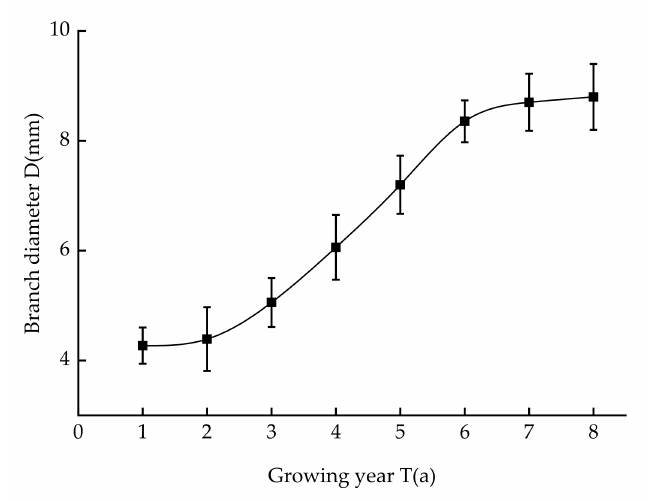
Figure 4. Relationship between branch diameter and growth year.